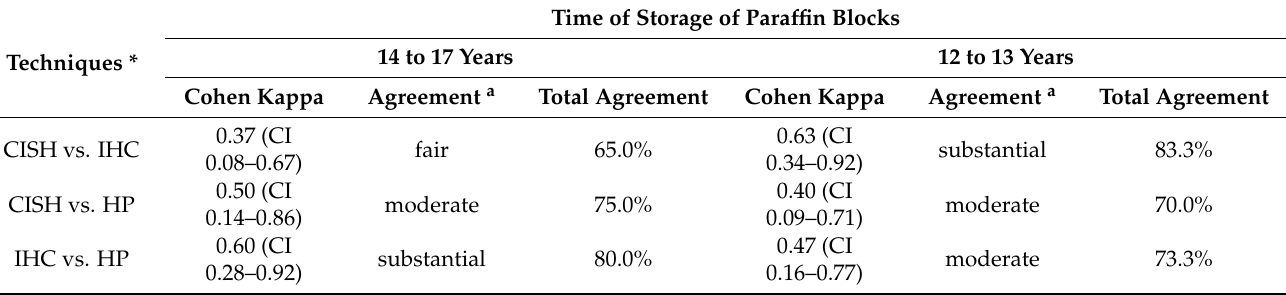
Table 5. Agreement between diagnosis techniques for the detection of amastigotes in samples fixed in 10% formalin and paraffin-embedded of cutaneous lesions according to the time of storage of paraffin blocks from patients with new world cutaneous leishmaniasis caused by L. ( V. ) braziliensis .